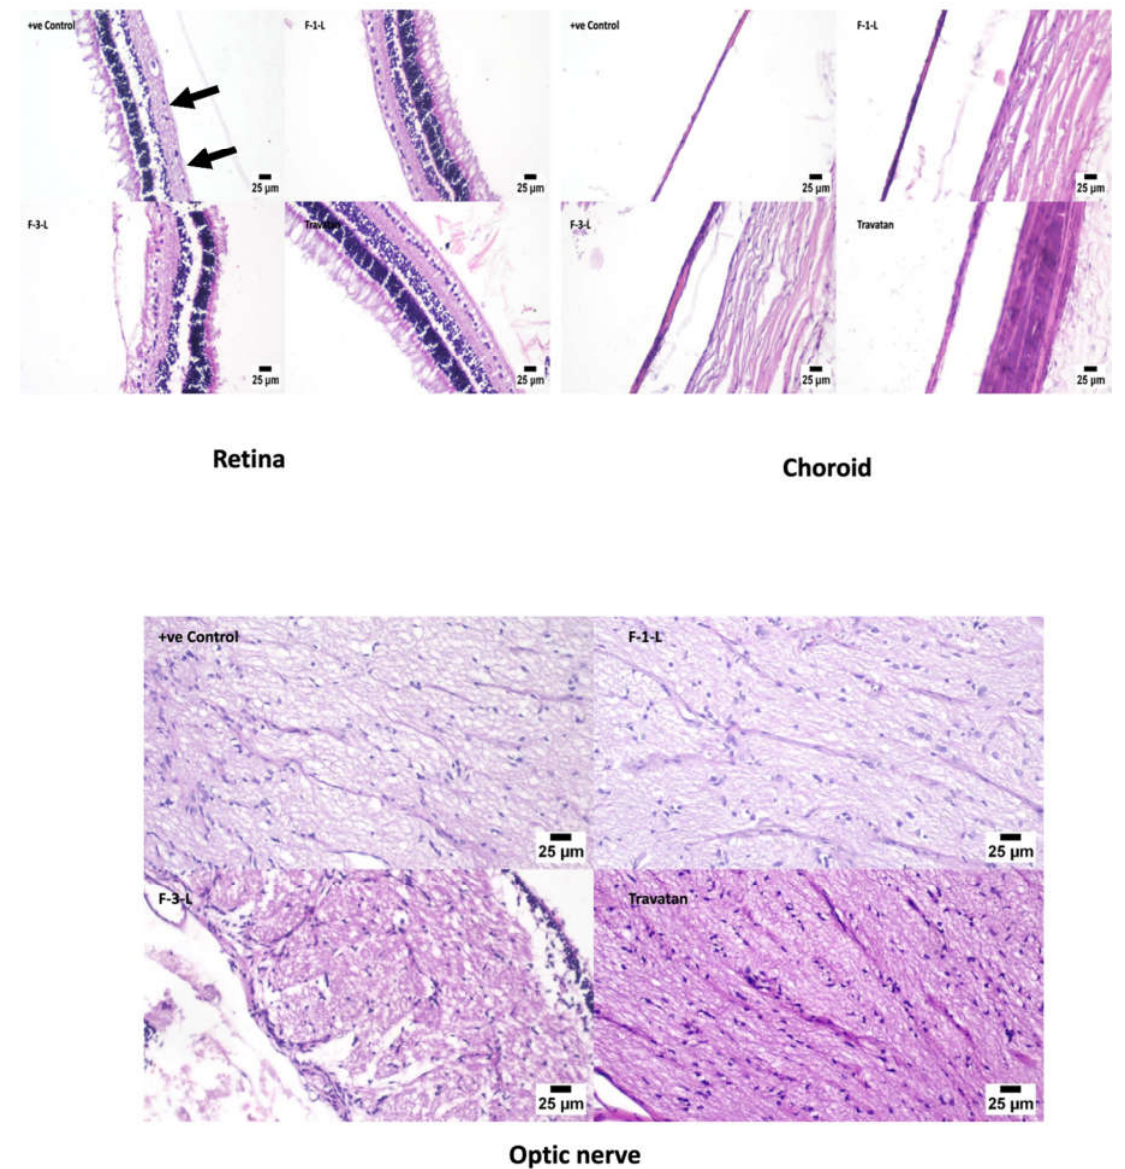
Figure 9. Photomicrographs of the eye of different sections of the tested samples. (*) denotes corneal edema, the black arrows point out undersized hyperchromatic ganglion cells with pyknotic nuclei.